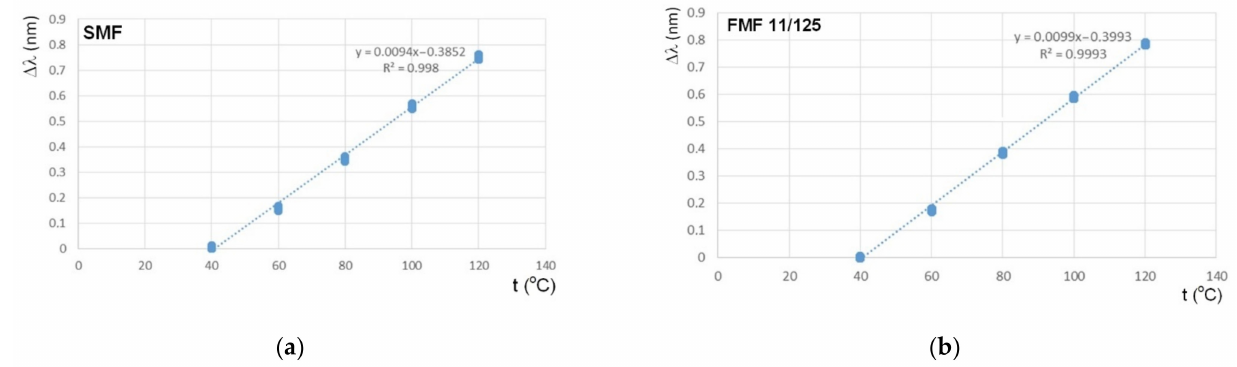
Figure 10. FBG Bragg wavelength λ B shifting sensitivity to the temperature action: ( a ) FBG on SMF; ( b ) FBG on FMF 11/125.